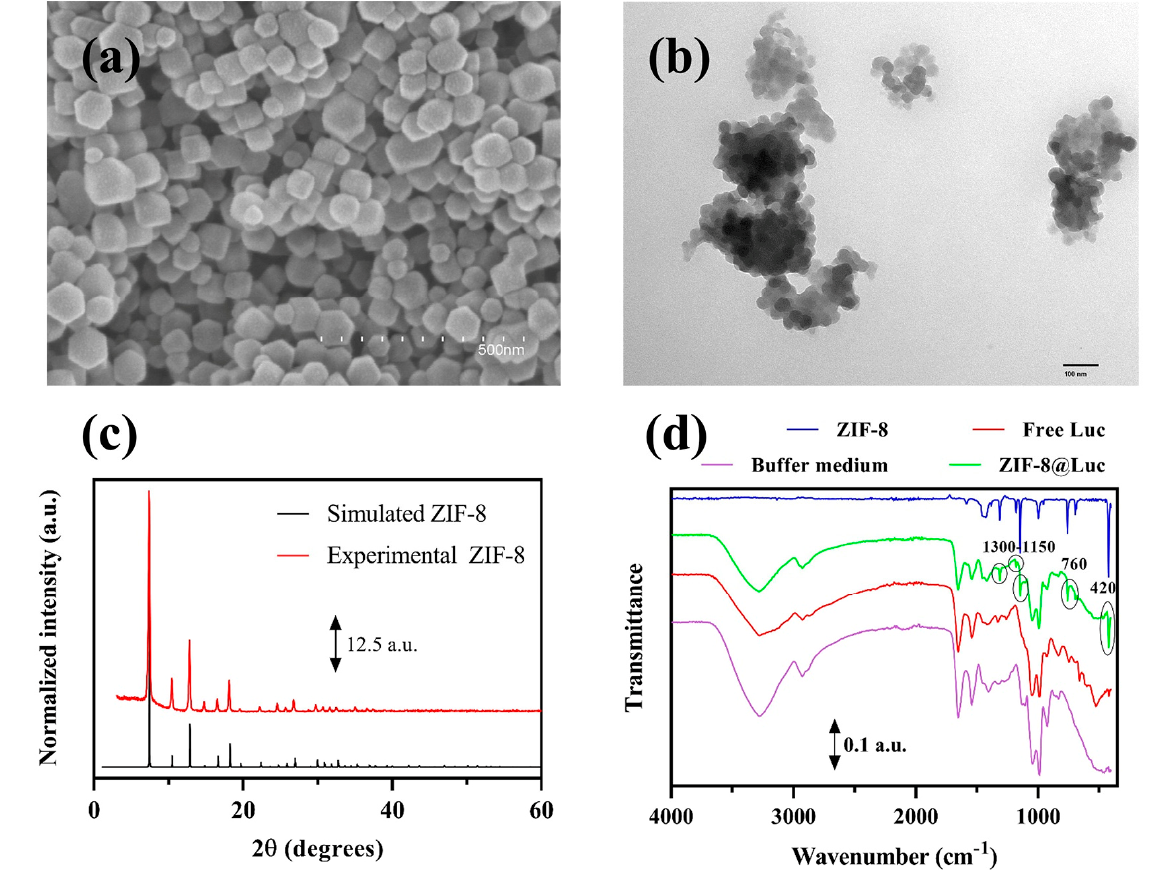
Figure 2. Chemical and structural characterization studies: ( a ) Scanning electron microscopy (SEM) image; ( b ) Transmission electron microscopy (TEM) image; ( c ) Powder X − ray diffraction (PXRD); ( d ) Fourier-transform infrared spectroscopy (FT − IR) spectra; details are available in Materials and Methods section.